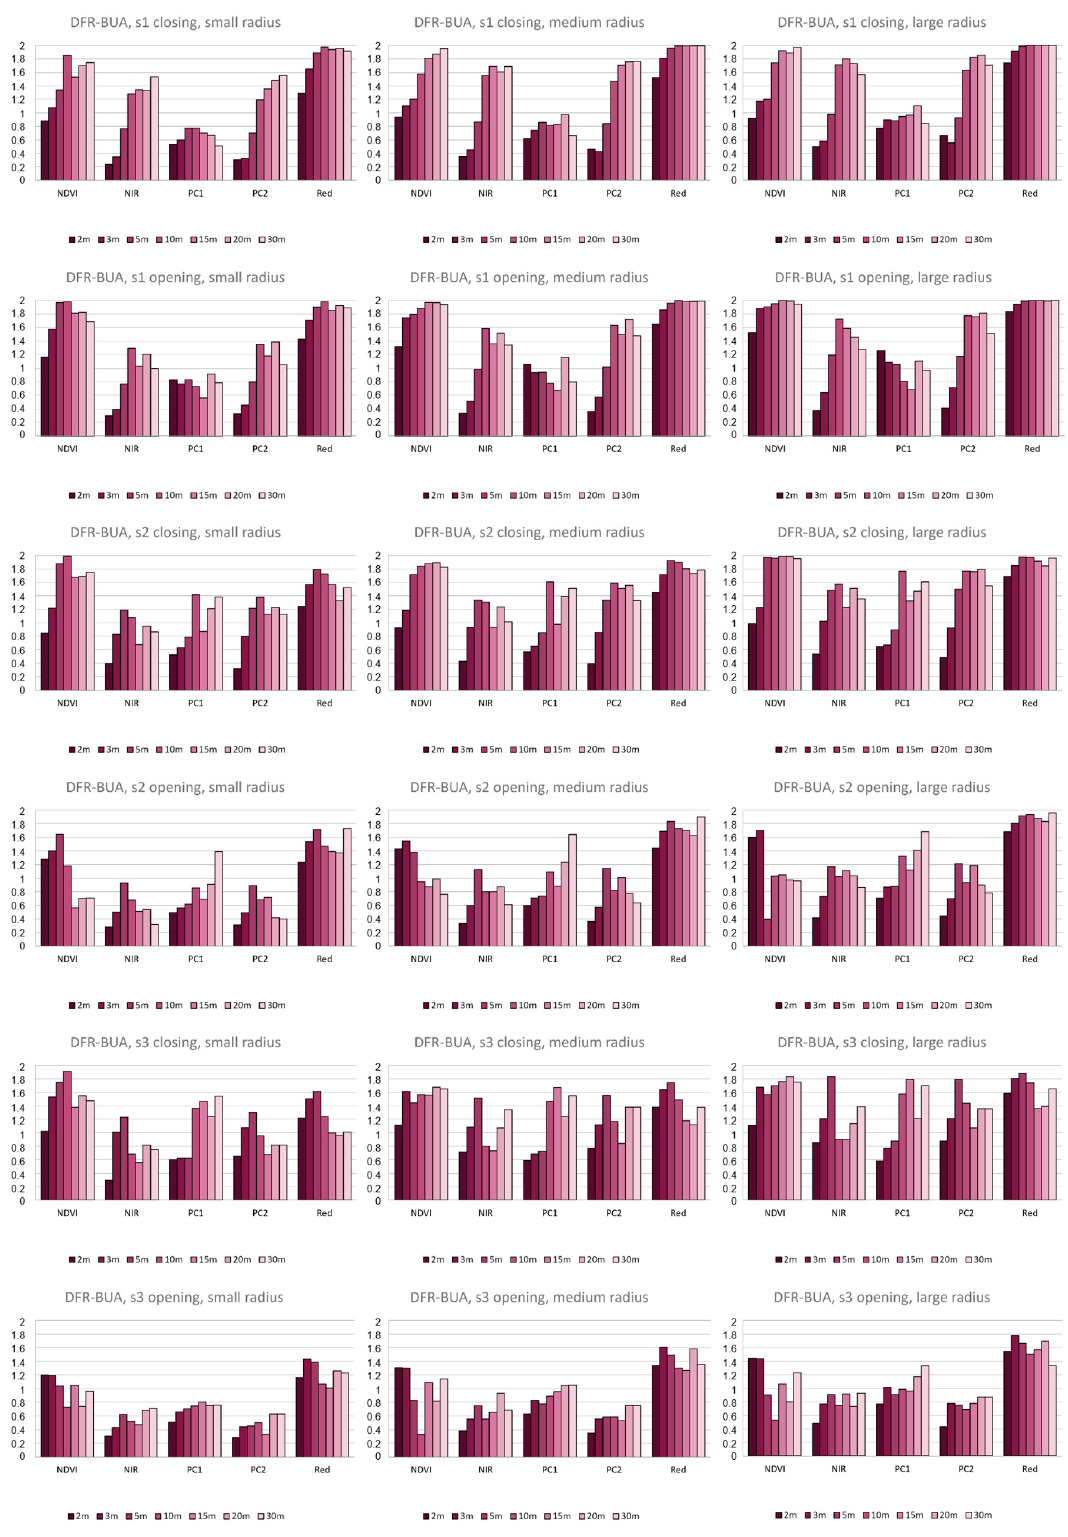
Figure 10. J–M distance diagrams for test fields for the deciduous forest/built-up area class pair (DFR/BUA).